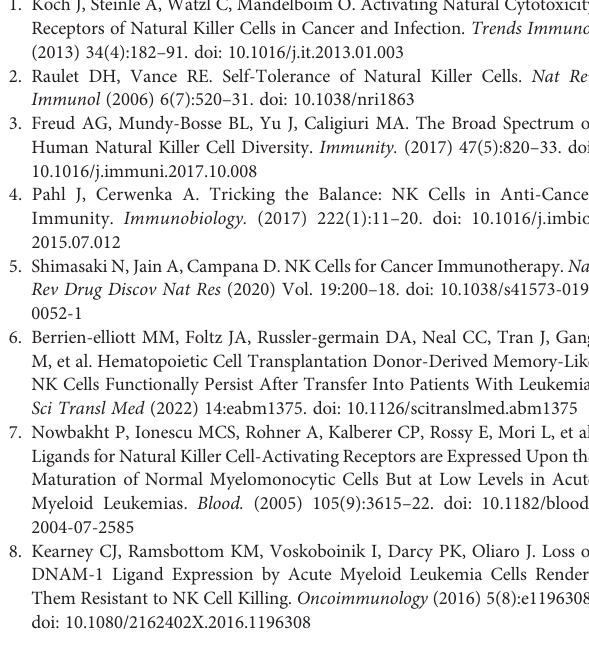
and functionality (77, 165, 166). Not only can the